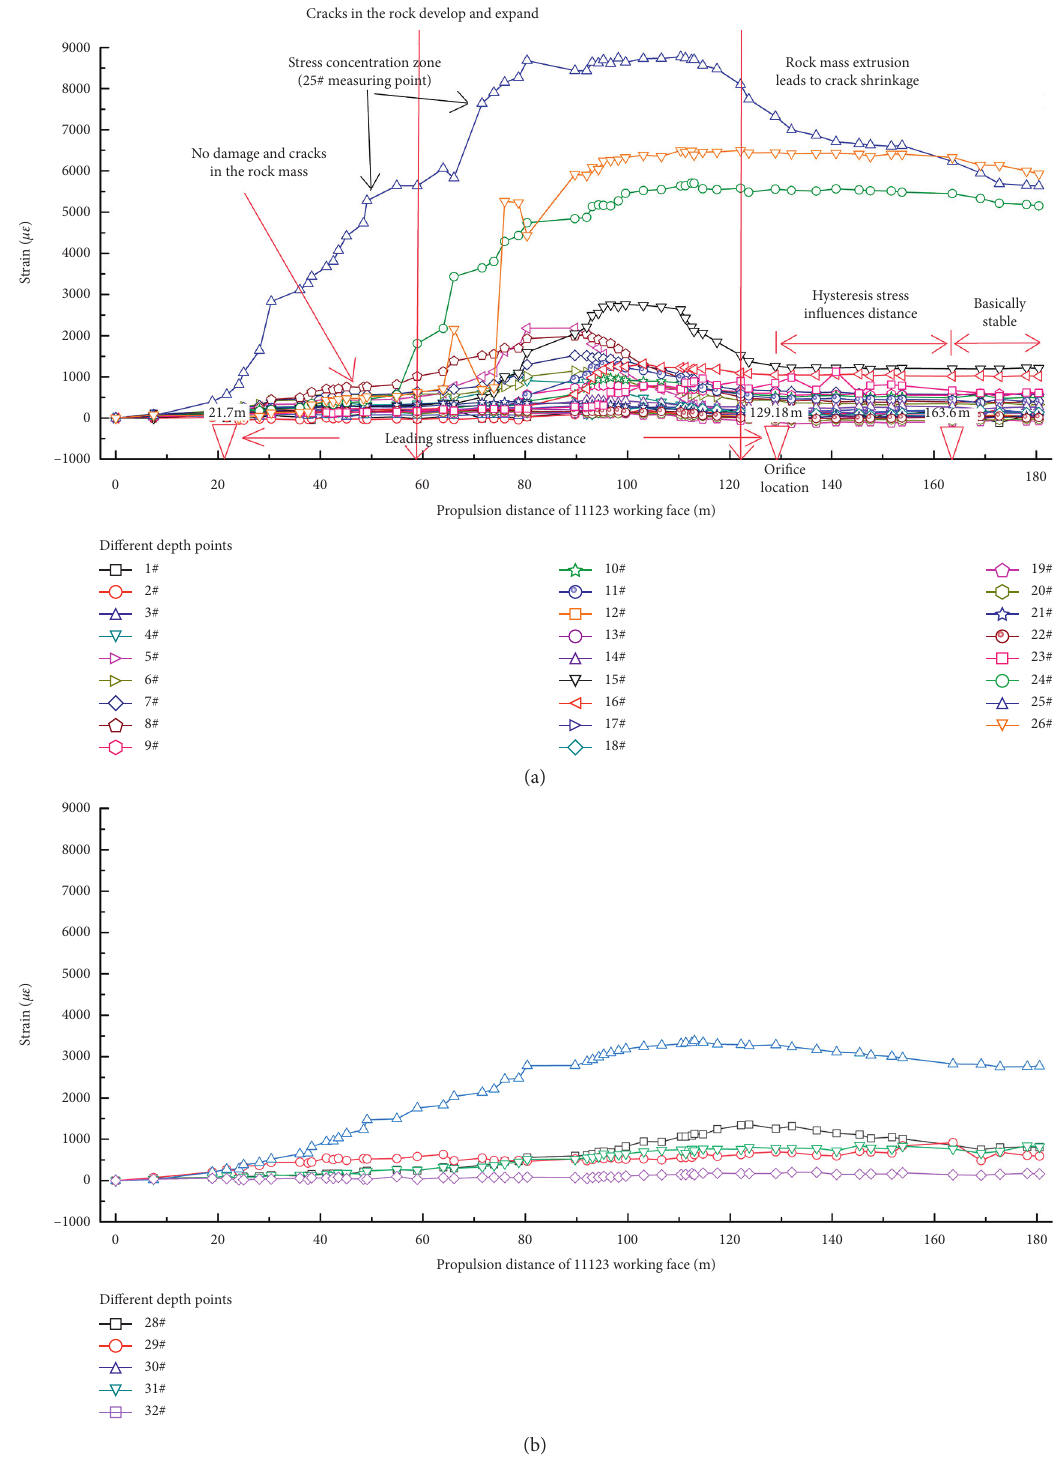
Figure 10: Variation of strain with advancing